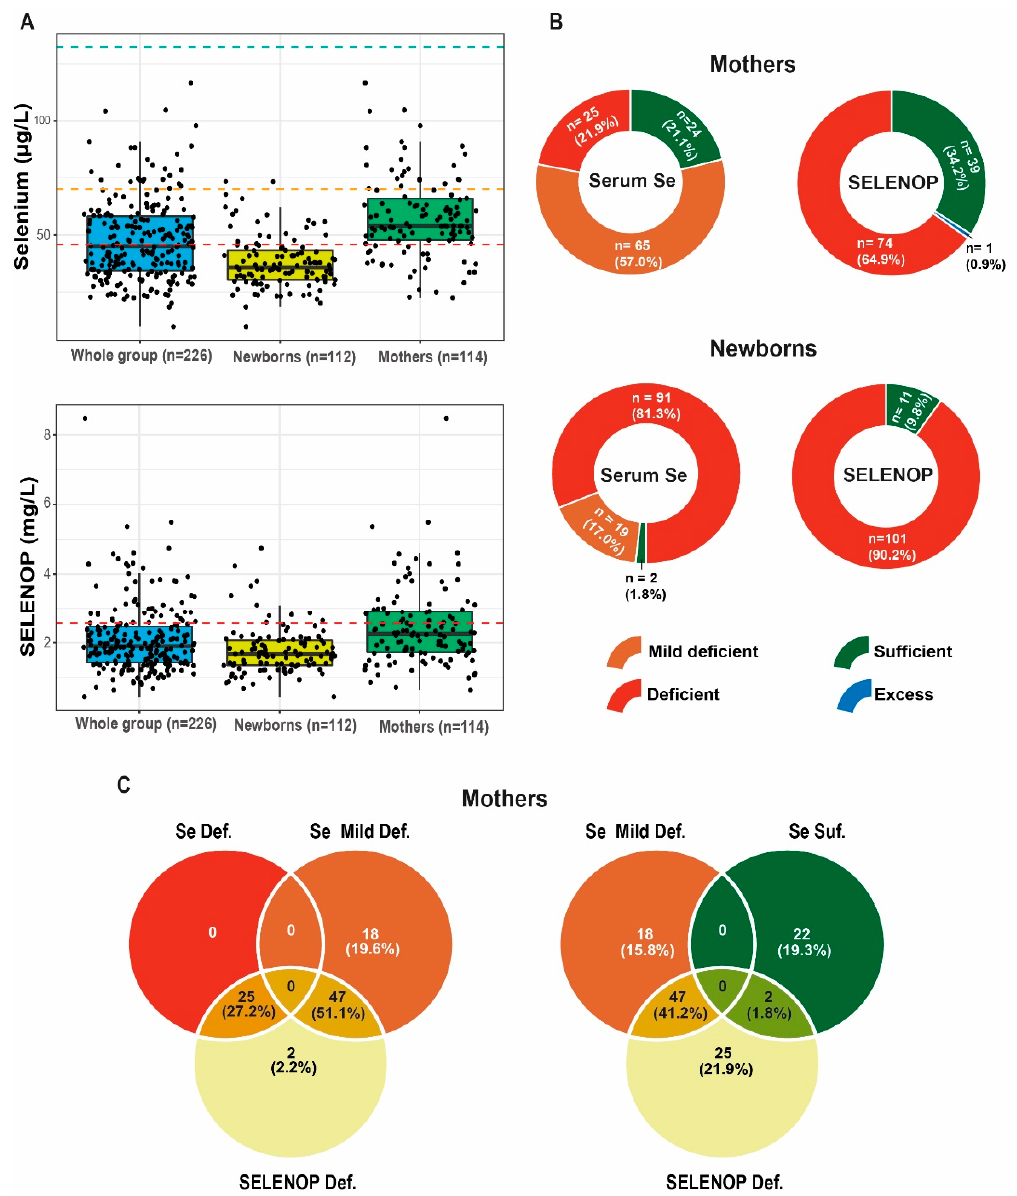
Figure 3. Overview of the Se status of the entire cohort. ( A ) Total serum Se and SELENOP was determined in the serum of the mothers and the newborns and categorized according to the range of EPIC-Study. Cut-off for deficiency: sufficiency; [Se] > 70 µg/L (green dashed line), mild deficiency; [Se] < 70 µg/L and >45.9 µg/L (orange dashed line) versus deficiency; [Se] < 45.9 µg/L (red dashed line). The majority of both mothers and newborns are below the commonly used threshold of 70 µg/L (mild deficiency). Cut-off for deficiency according to the SELENOP status: excess; [SELENOP] > 6.63 mg/L, sufficiency; [SELENOP] < 6.63 mg/L and >2.56 mg/L, versus deficiency; [SELENOP] < 2.56 mg/L (red dashed line). The majority of both mothers and newborns are below the threshold of 2.56 mg/L (deficiency). ( B ) Doughnut charts presenting the relative fraction of subjects with sufficient or deficient Se status according to the serum Se and SELENOP, respectively. ( C ) Venn diagrams highlighting the overlap and discordance of the simultaneous Se and SELENOP deficiency.